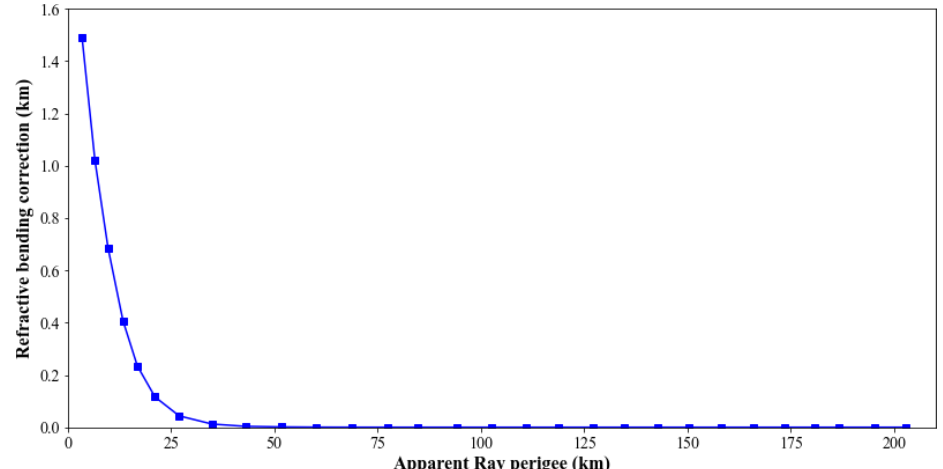
Figure C1. Correction to ray perigee to account for refractive bending with ray-tracing algorithm.